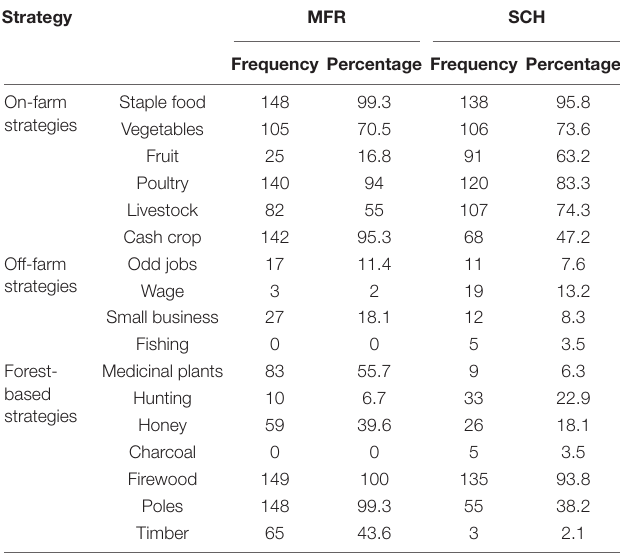
TABLE 5 | Engagement in different livelihood strategies in MFR and SCH (number and percentage of households). Strategy MFR